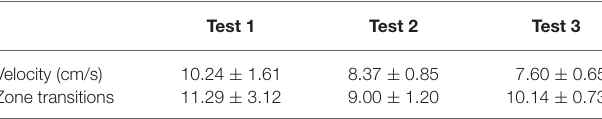
TABLE 1 | Velocity and zone transitions during each testing